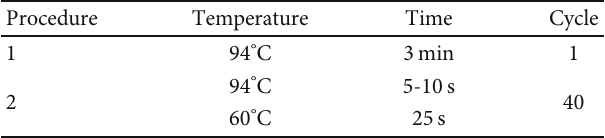
Table 3: The procedure of